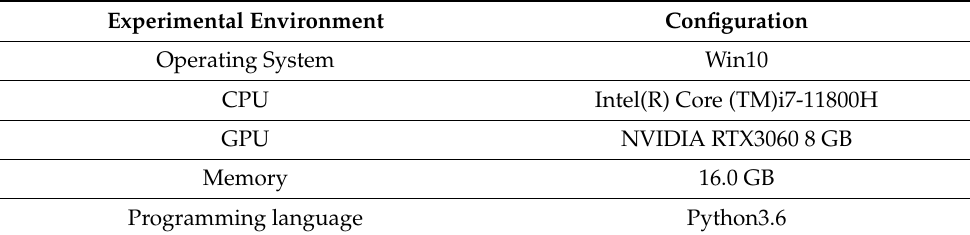
Table 6. Experimental environment